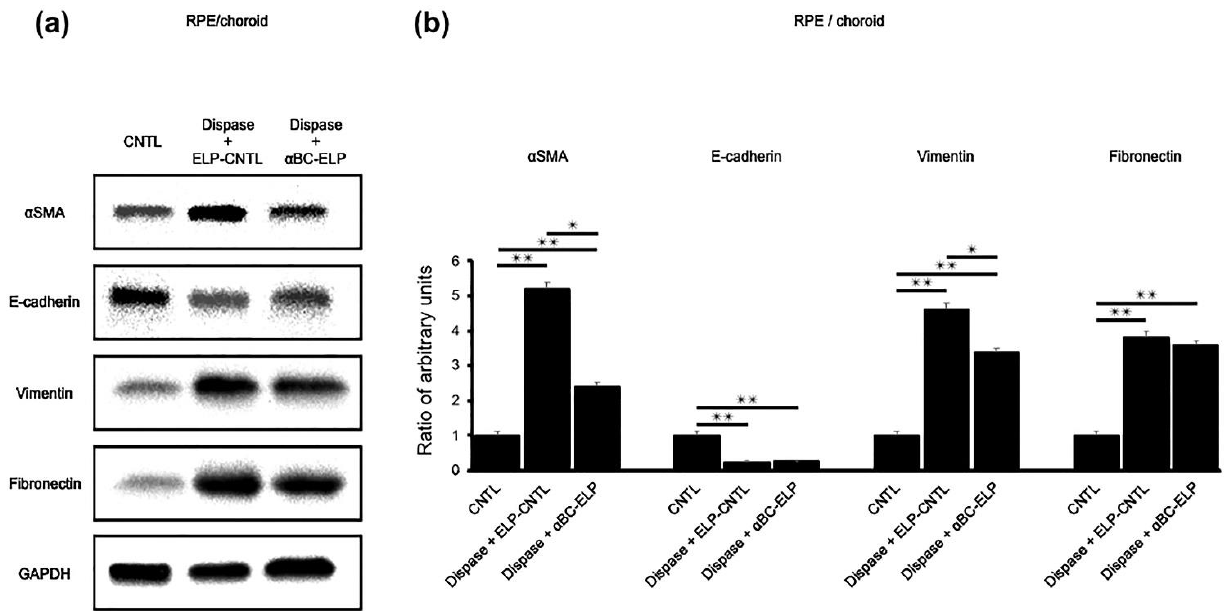
Figure 11. Regulation of EMT- and MET-associated proteins by α BC-ELP in dispase-induced PVR in mice. The experimental protocol is shown in Figure 8a. Protein expression was measured by Western blot analysis ( a ). EMT-associated proteins ( α SMA, Fibronectin and Vimentin) significantly increased with dispase treatment, and α BC-ELP treatment significantly inhibited their expression ( b ). MET-associated protein (E-cadherin) had no significant difference with α BC-ELP treatment, and α BC-ELP treatment did not alter the expression ( b ). Values are means ± SEM. N.S.: not significant, α BC-ELP: α B crystallin-Elastin-like peptide. * p < 0.05, ** p < 0.01. n = 3.